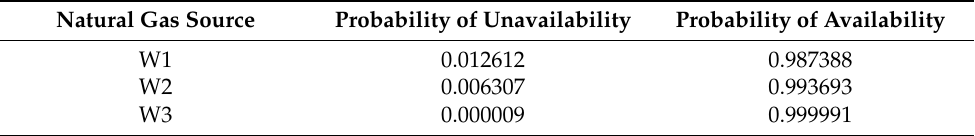
Table A9. Availability and unavailability of natural gas sources in the western gas